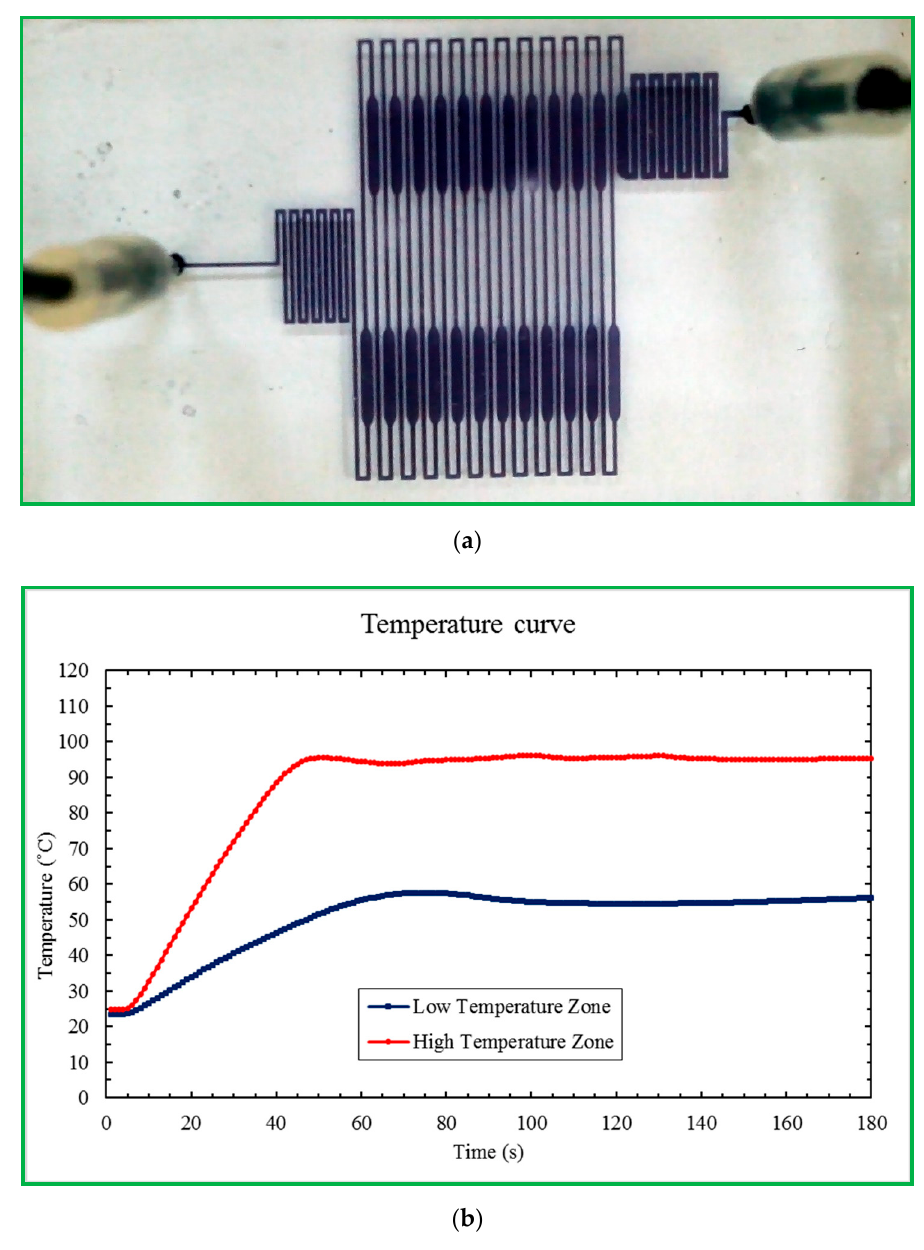
Figure 10. ( a ) The channel pattern of the fabrication microfluidic chip. ( b ) The measured temperatures at the annealing zone (Low Temperature Zone) and denaturation zone (High Temperature Zone) of the CFPCR chip.